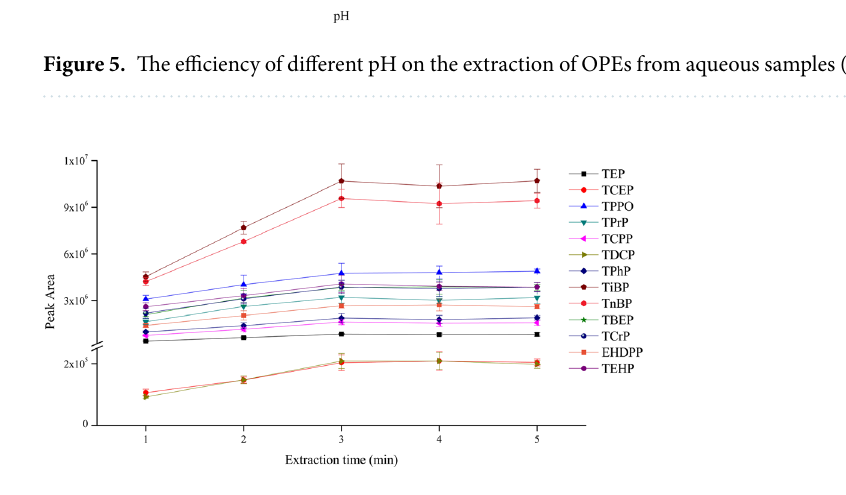
Figure 6. The efficiency of different extraction time on the extraction of OPEs from aqueous samples (n =